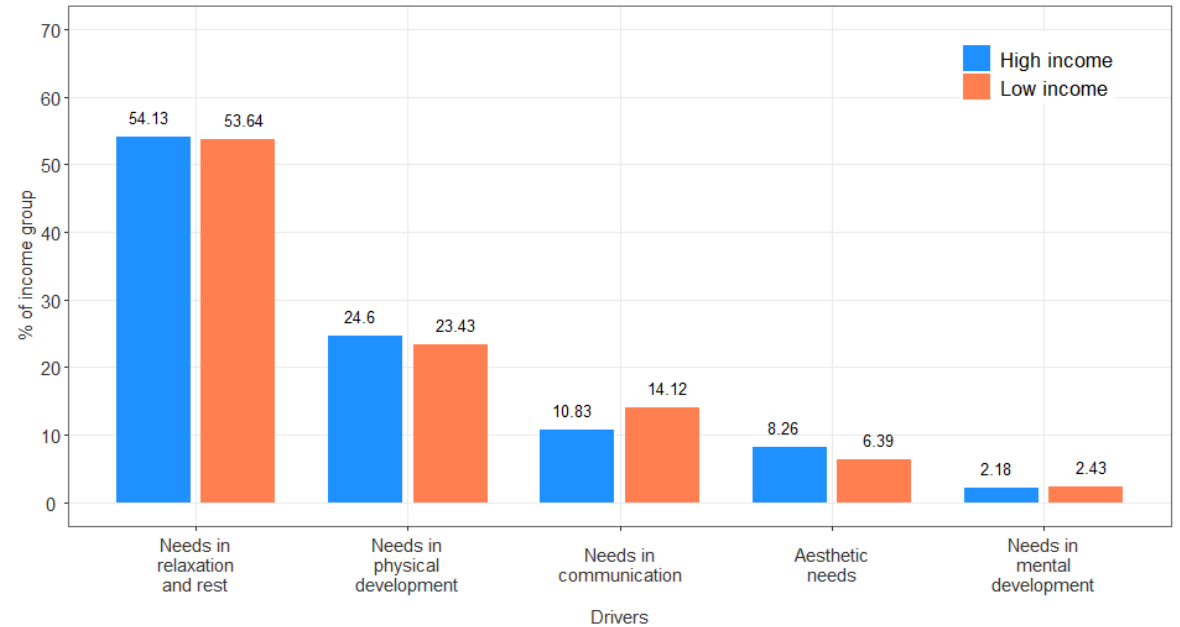
Figure 6. Percentage distribution of the main drivers for forest recreation activities among the respondents from the different income groups.